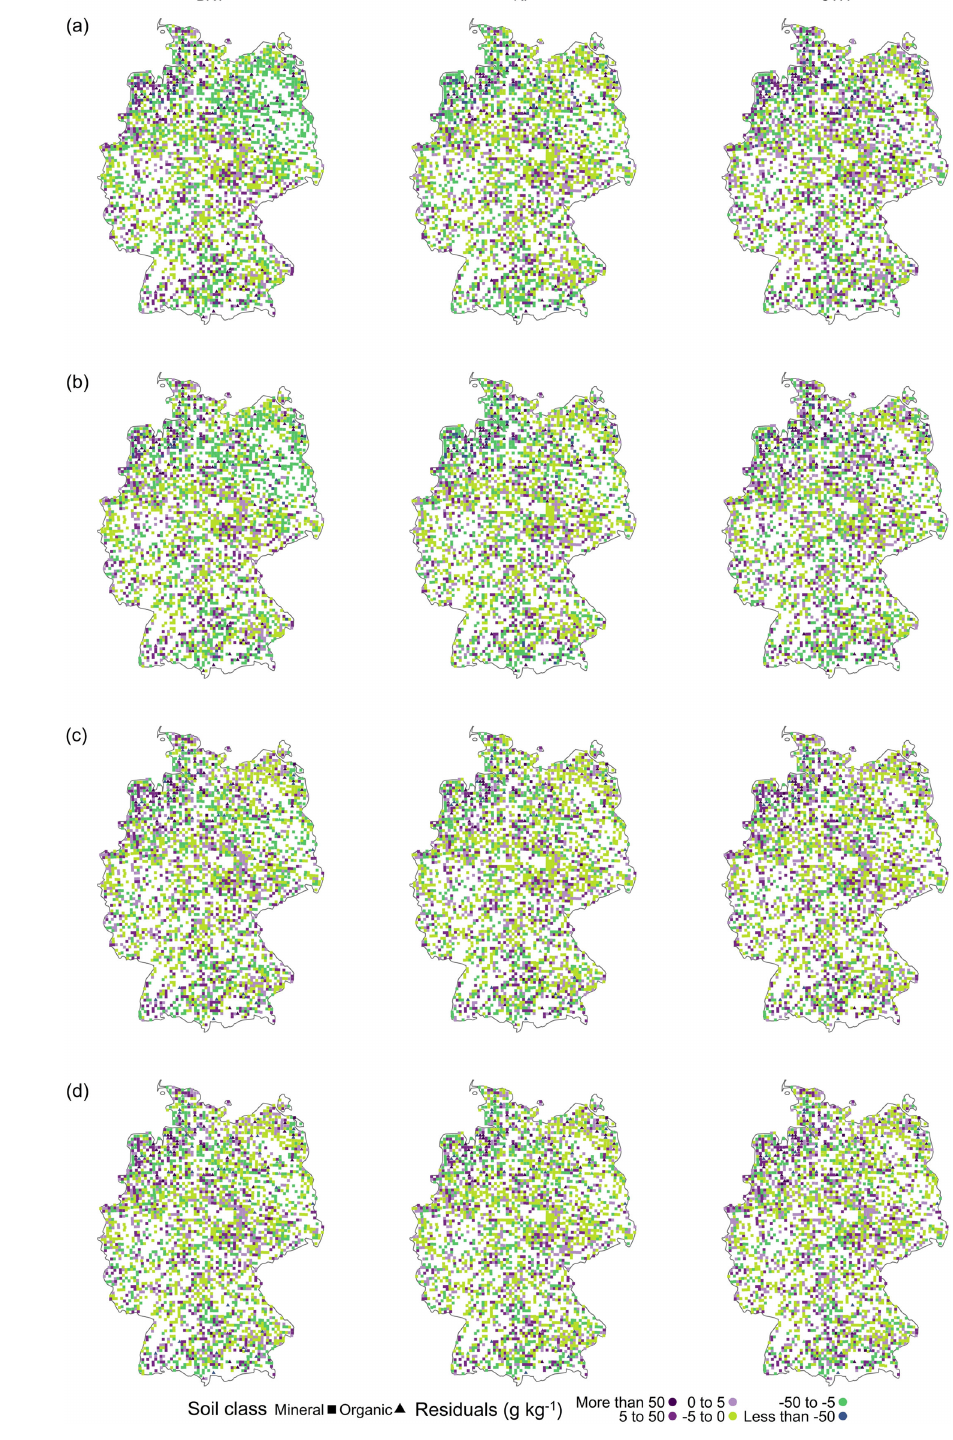
Figure 6. Spatial distribution of residuals for (a) the AP1 approach, (b) the AP1L approach, (c) the AP2 approach, and (d) the AP2L approach. The abbreviations used in the figure are as follows: BRT – boosted regression trees, RF – random forest, and SVR – support vector